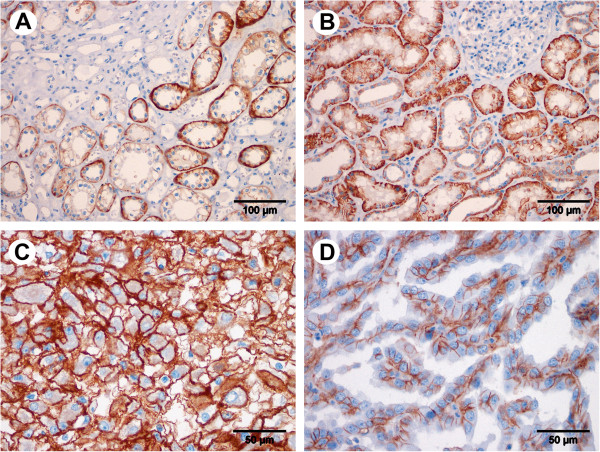
Immunostaining of EMMPRIN in renal cell tissue. EMMPRIN expression was detected in the tubuli of non-malignant renal tissue as shown in the medulla (A) and in the cortex of the kidney (B). Clear cell (C) and papillary (D) carcinoma tissues are shown exemplary for tumor staining. Magnification: 200× (A, B), 400× (C, D).